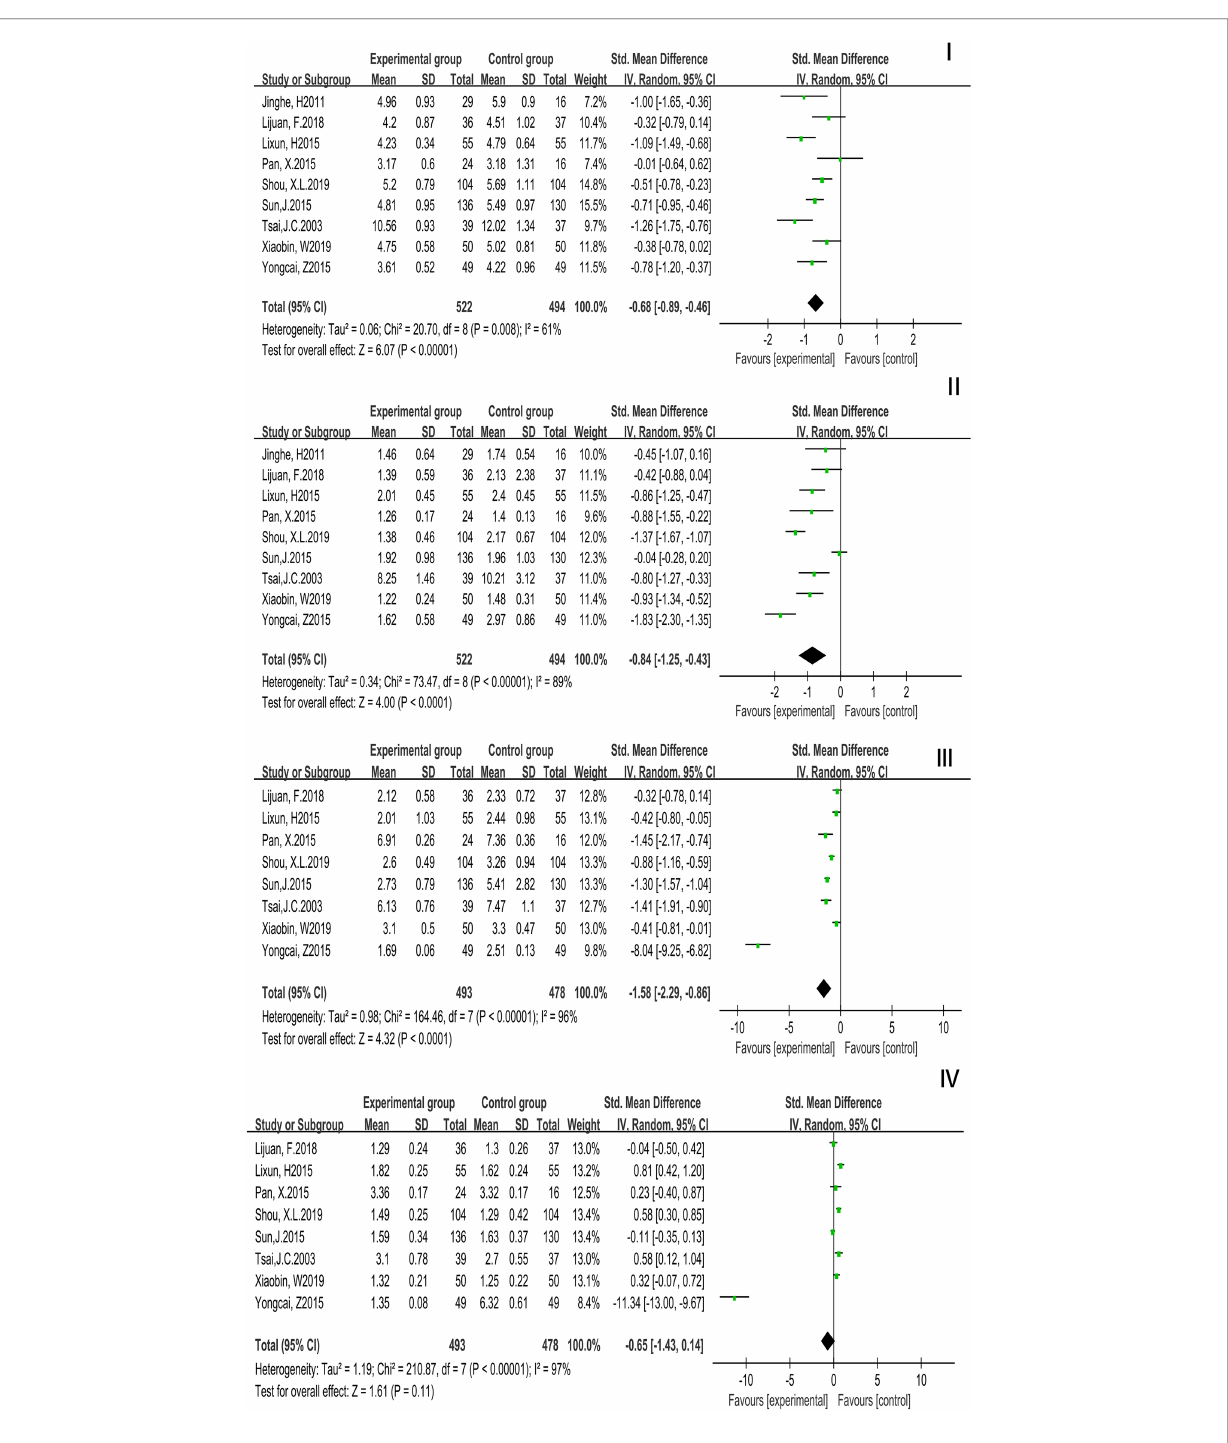
FIGURE 7 Forest plot of meta-analysis on the effect of Tai Chi exercise cycle on blood lipid related indexes (cycle ≥ 12 weeks). I, Total Cholesterol (TC); II, Triglyceride (TG); III, Low Density Lipoprotein (LDL-C); IV, High Density Lipoprotein